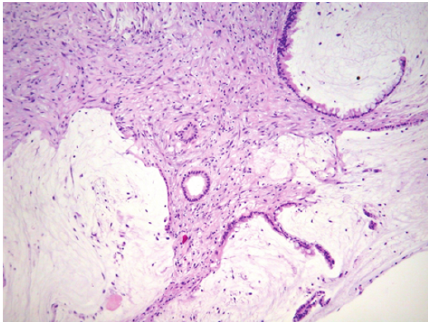
Figure 1: Noninvasive mucinous peritoneal implants or low-grade pseudomyxoma peritonei (PMP), also known as “disseminated peritoneal adenomucinosis” (DPAM).